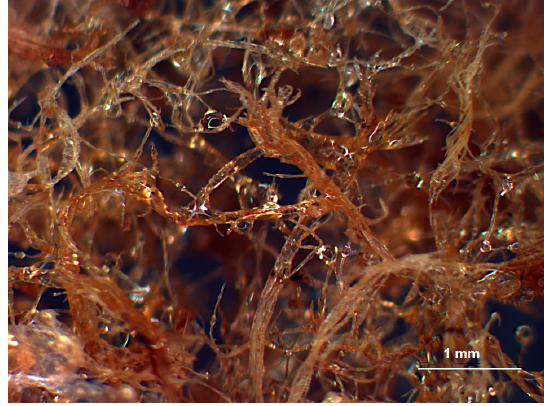
Figure 9. Optical Image of 33% Vinyester resin and MDF fiber.